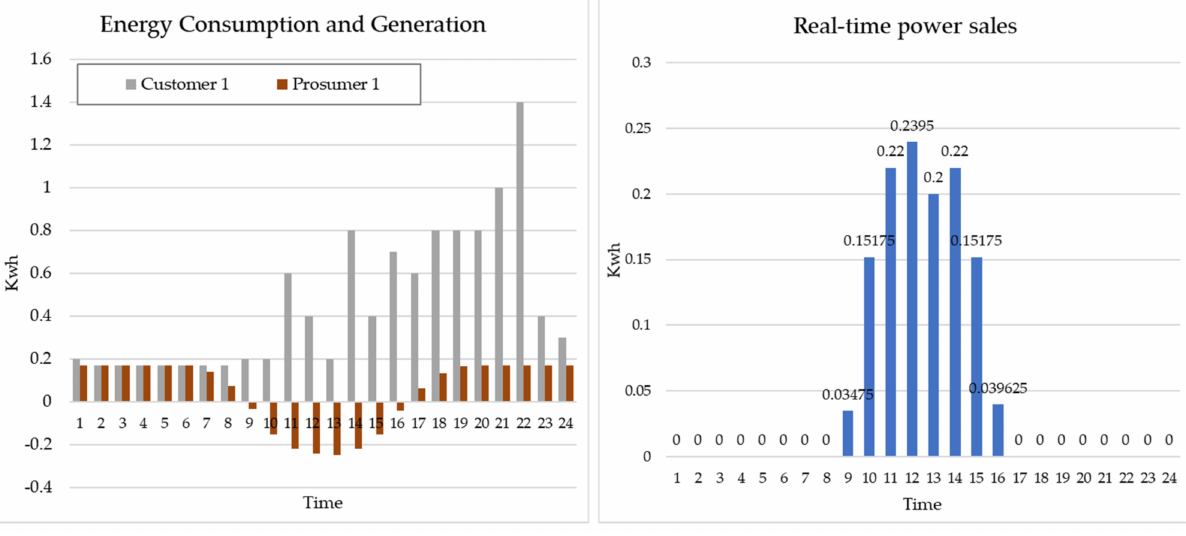
Figure 12. Real-time status of Prosumer 1 and Customer